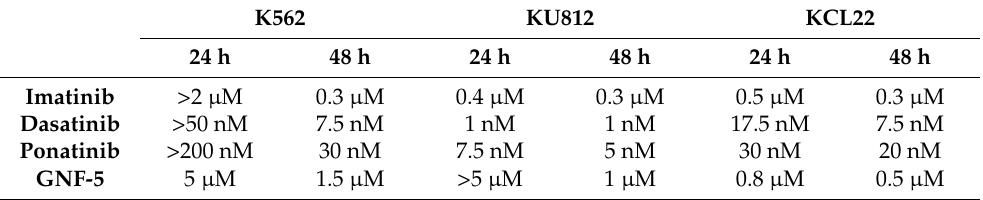
Table 1. The IC 50 values of imatinib, dasatinib, ponatinib and GNF-5 in three CML cell